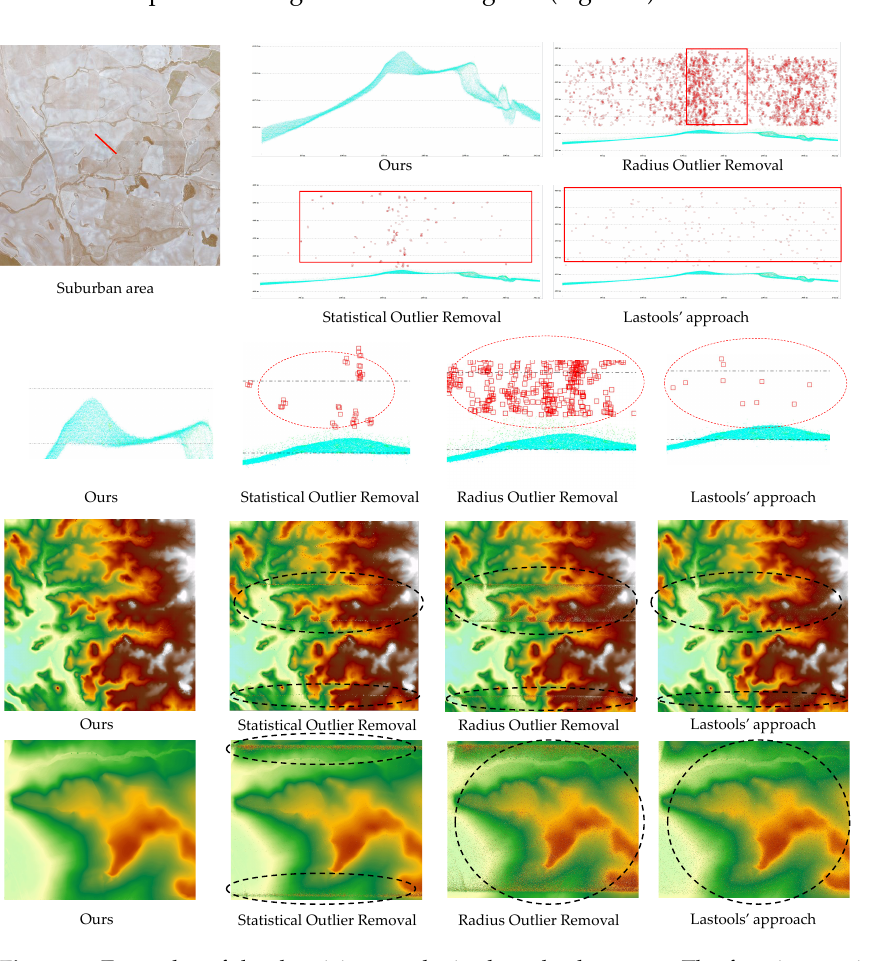
Figure 7. Examples of the denoising results in the suburban area. The four images in the upper right-hand corner show the profile line in the area of the red line on the left. The third row repre- sents the profile line partial details for convenient comparison. The fourth row indicates the DSM generated by the different denoising methods. The bottom row indicates some details of the DSM to facilitate